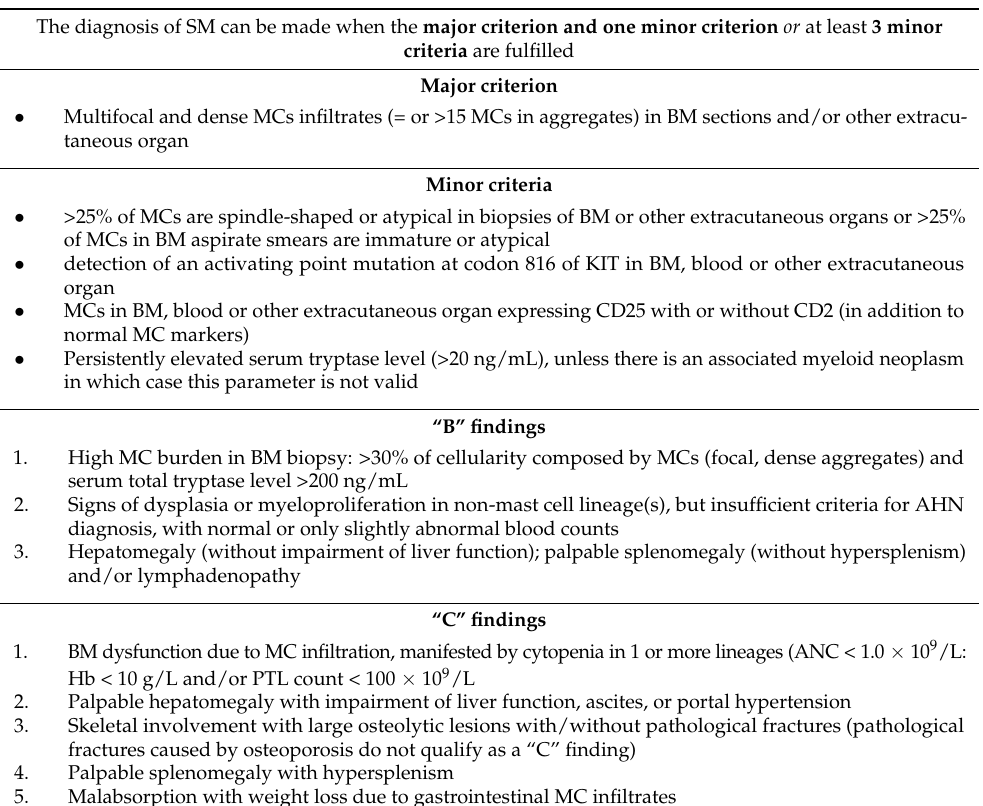
Table 2. WHO diagnostic criteria for systemic